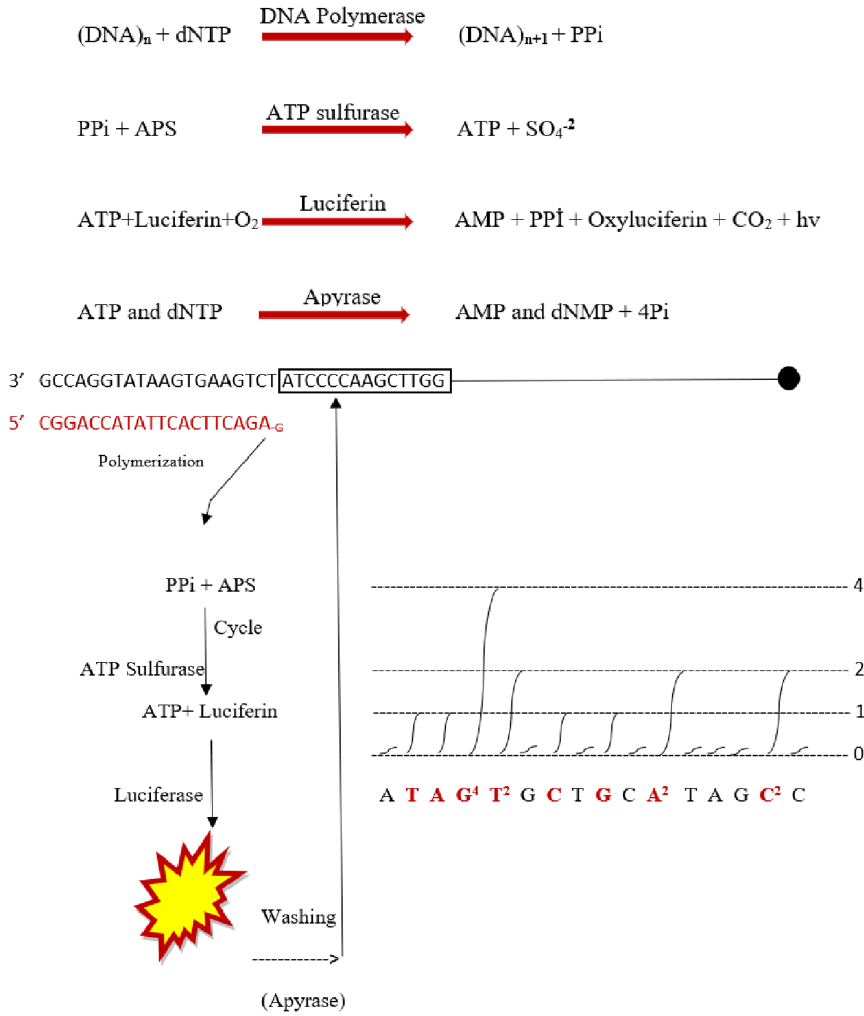
Figure 2. Principle of Roche 454 method (G: guanine, A: adenine, C: cytosine, T: thymine, dNTPs: deoxyribonucleotide triphosphate, ATP: adenosine triphosphate, AMP: adenosine monophosphate, dNMP: deoxyribonucleoside monophosphate, APS: adenosine 5 ′ -phosphosulfate sodium salt, PPİ: pyrophosphate, Pi: phosphatase, hv: emission of